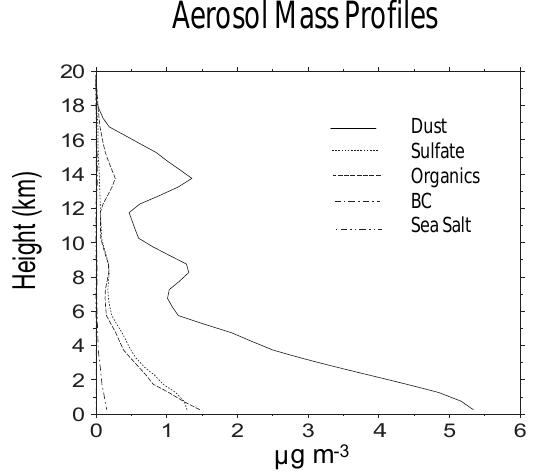
Fig. 2. Vertical profiles of aerosol species. Salt is present, but its values are less than 0.01µgm − 3 .